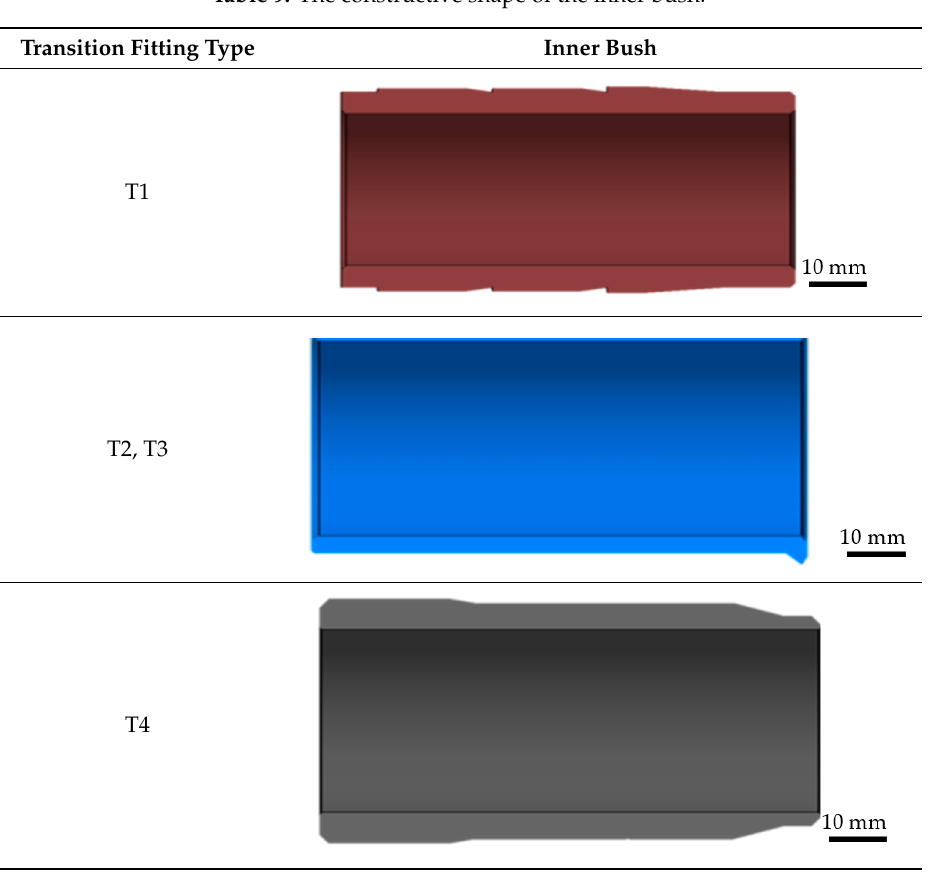
Table 9. The constructive shape of the inner bush.